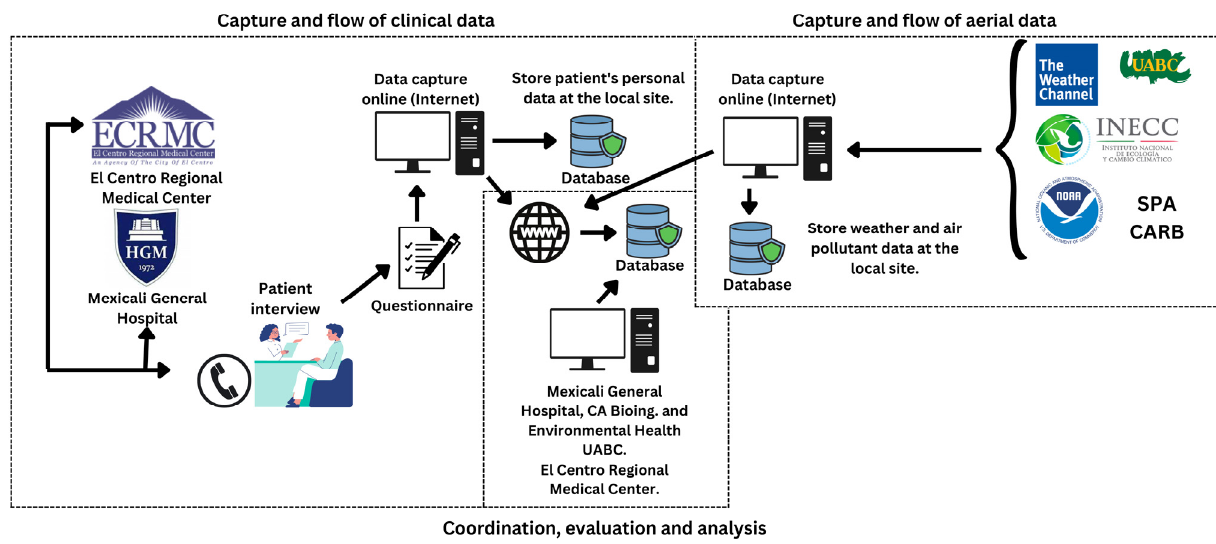
Figure 1. Binational surveillance system proposed for Mexicali B.C.-Imperial Valley.